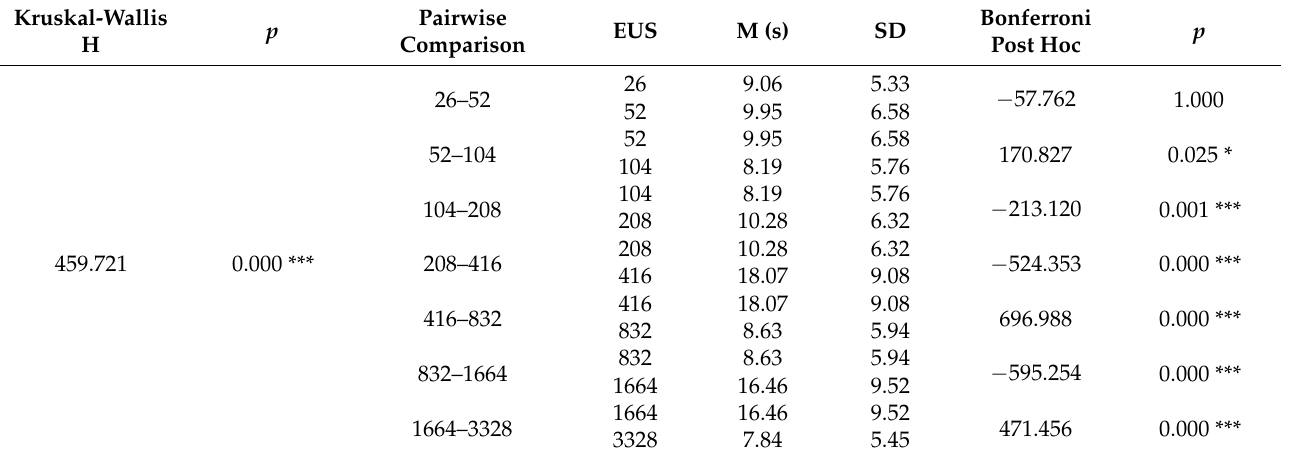
Table 6. Task 4 and the pairwise comparison of the answer times, * p < 0.05, *** p ≤ 0.001.